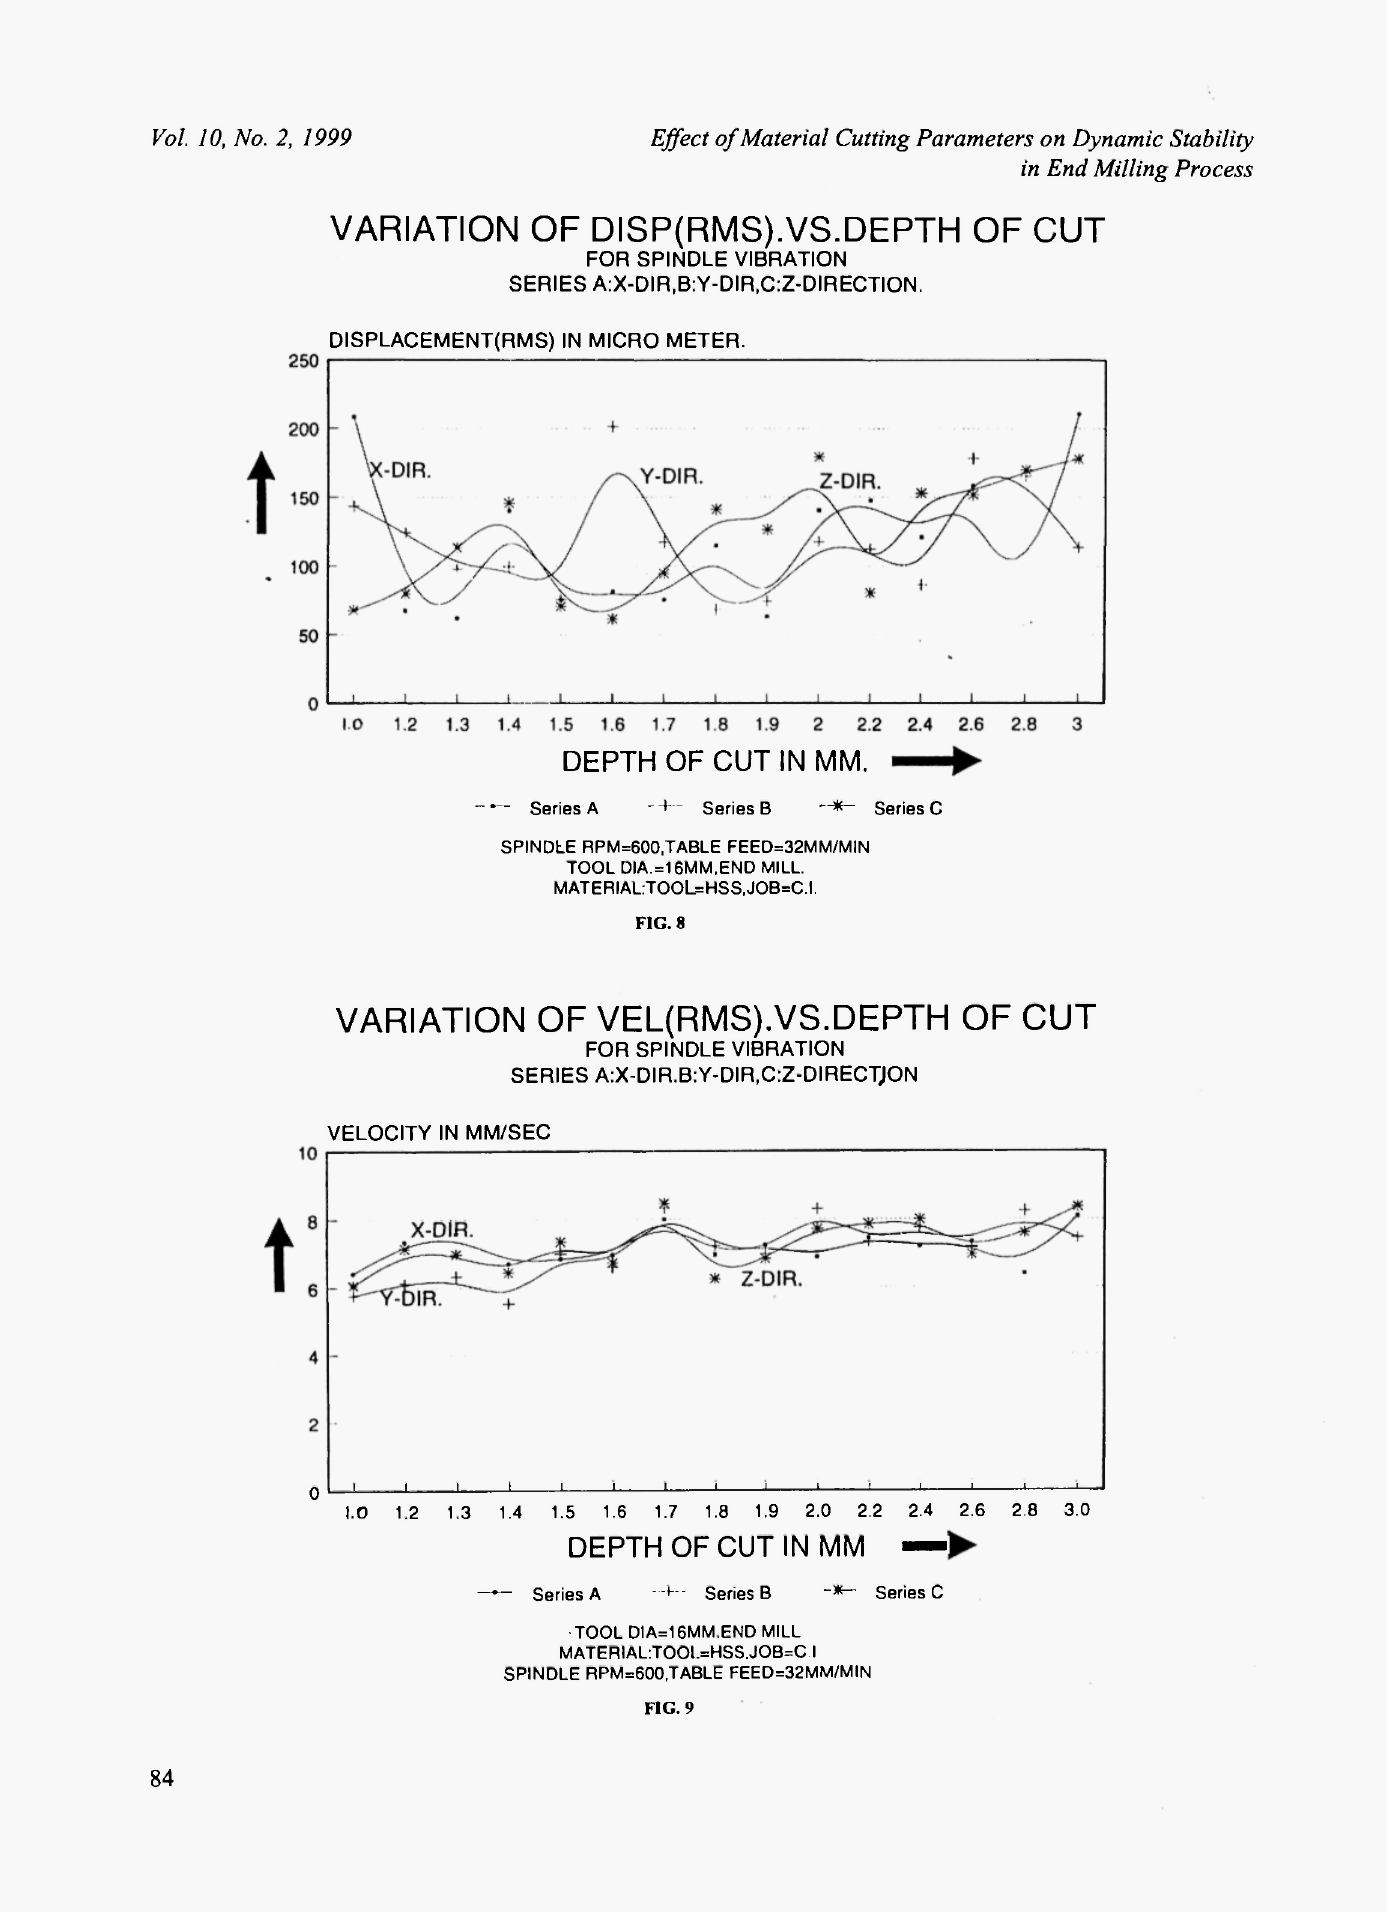
SPINDLE RPM=600,TABLE FEED=32MM/MIN TOOL DIA.=16MM,END MILL.